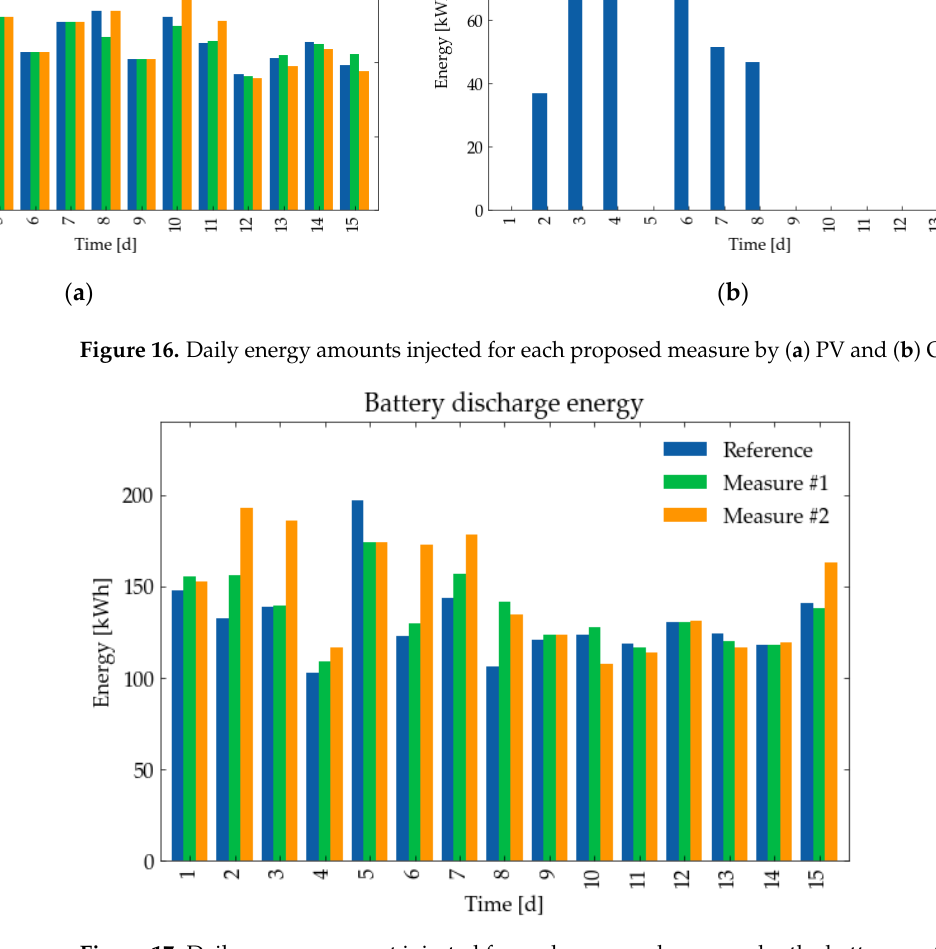
Figure 17. Daily energy amount injected for each proposed measure by the battery system.